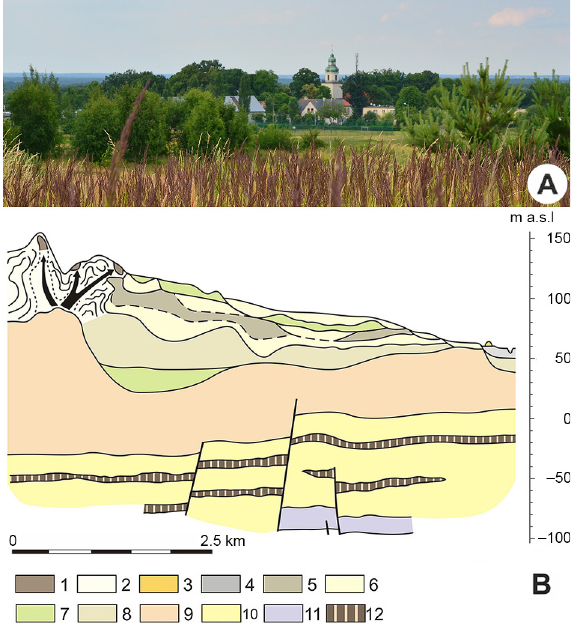
Fig. 6. Urban geosite of the Moraska Góra (Morasko